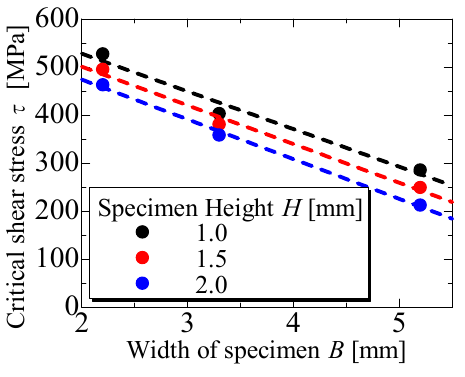
Figure 8. Influence of specimen width on failure shear stress: Apparent failure stress decreases with increasing specimen width.